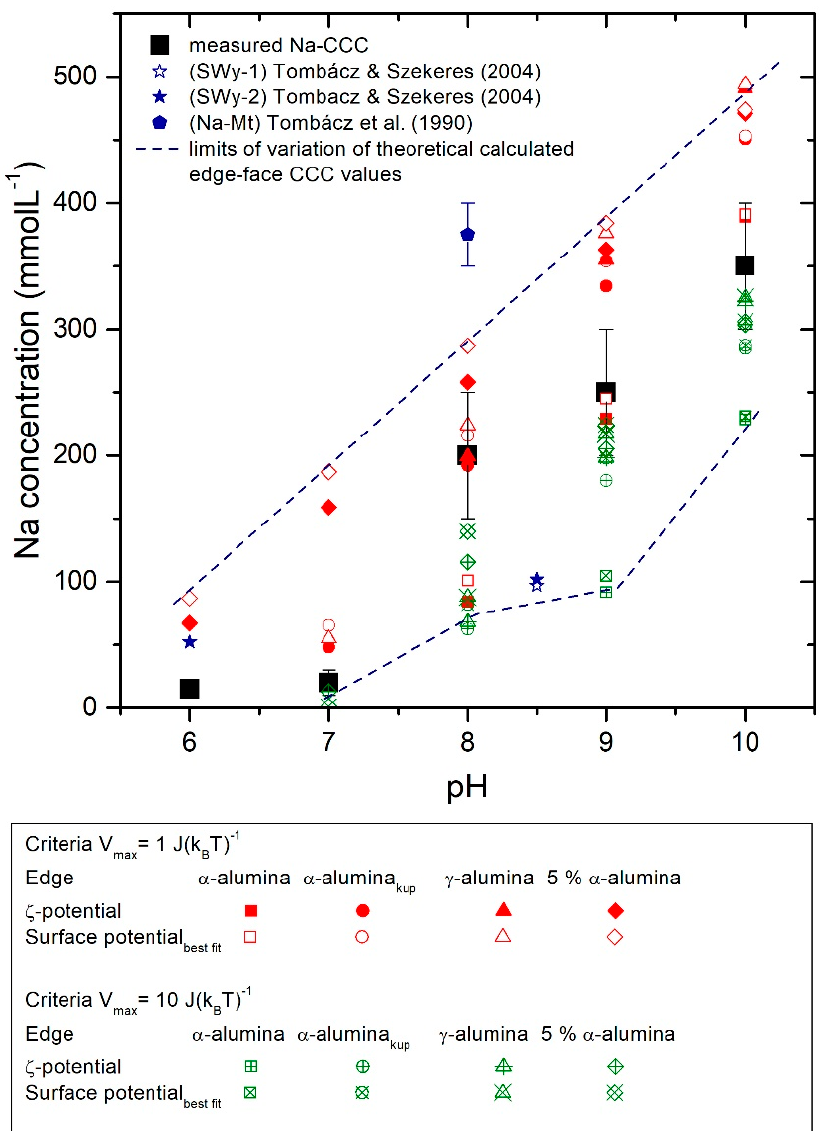
Figure 10. Concentrations fitted with the DLVO model to reach the criteria V max ≤ 1 Jk B − 1 T − 1 or V max ≤ 10 Jk B − 1 T − 1 , respectively, for the EF mode of interaction. The fitted ζ -potential of the FEBEX bentonite colloids (see Figure 6a) and the best fit surface electrokinetic potential (see Figure 6b), and the edge electrokinetic potential calculated with α -alumina (see Figure 7a), α -alumina Kup (see Figure 7b), γ -alumina (see Figure 7c), and 5% structural Al-ratio (see Figure 7d) are used. As comparison, the measured Na-CCC values as well as literature data from Tombácz and Szekeres [59] and Tombácz et al. [60] are given.